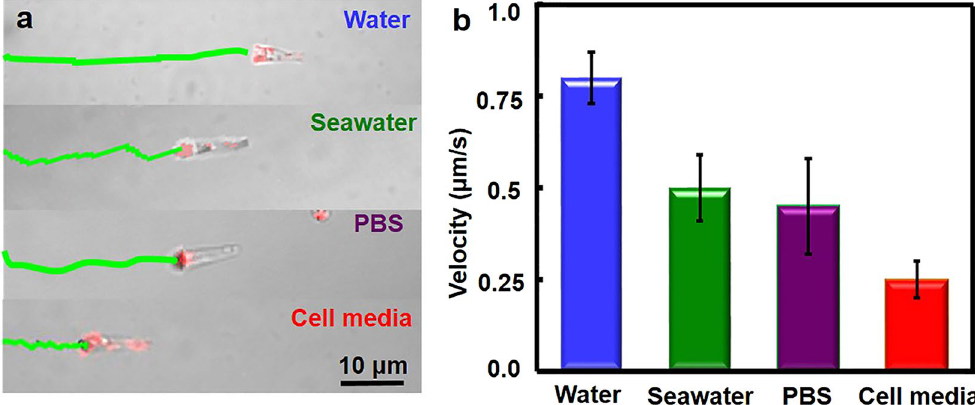
Figure 5. Torpedo Motors Move in Different Media. ( a ) The images showing the NIR movement of the torpedo motors in water, salt solution, PBS, and cell media. ( b ) Speed of the torpedo upon the 5.5 J cm − 2 laser power in different